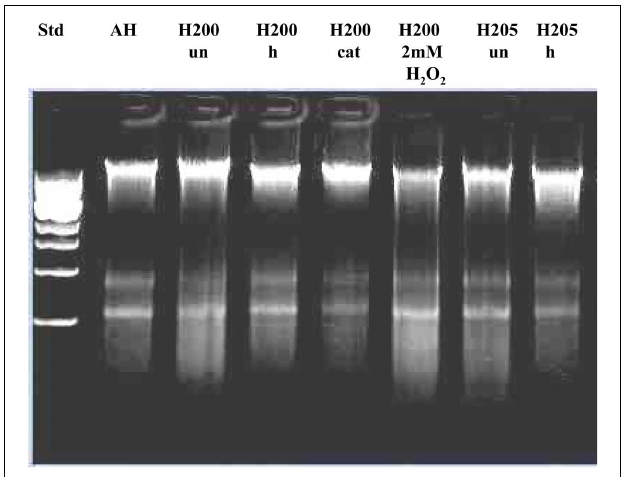
FIGURE 6 | Effect of exposure of E. coli cultures to heat-treated (h), catalase-treated (cat), and untreated (un) honeys on the integrity of chromosomal DNA. AH-cell treated with artificial honey, or buckwheat honeys H200, and H205. Lane “H200 2mM H 2 O 2 ” represents the effect of honey H200 supplementation with hydrogen peroxide on the E. coli DNA integrity.